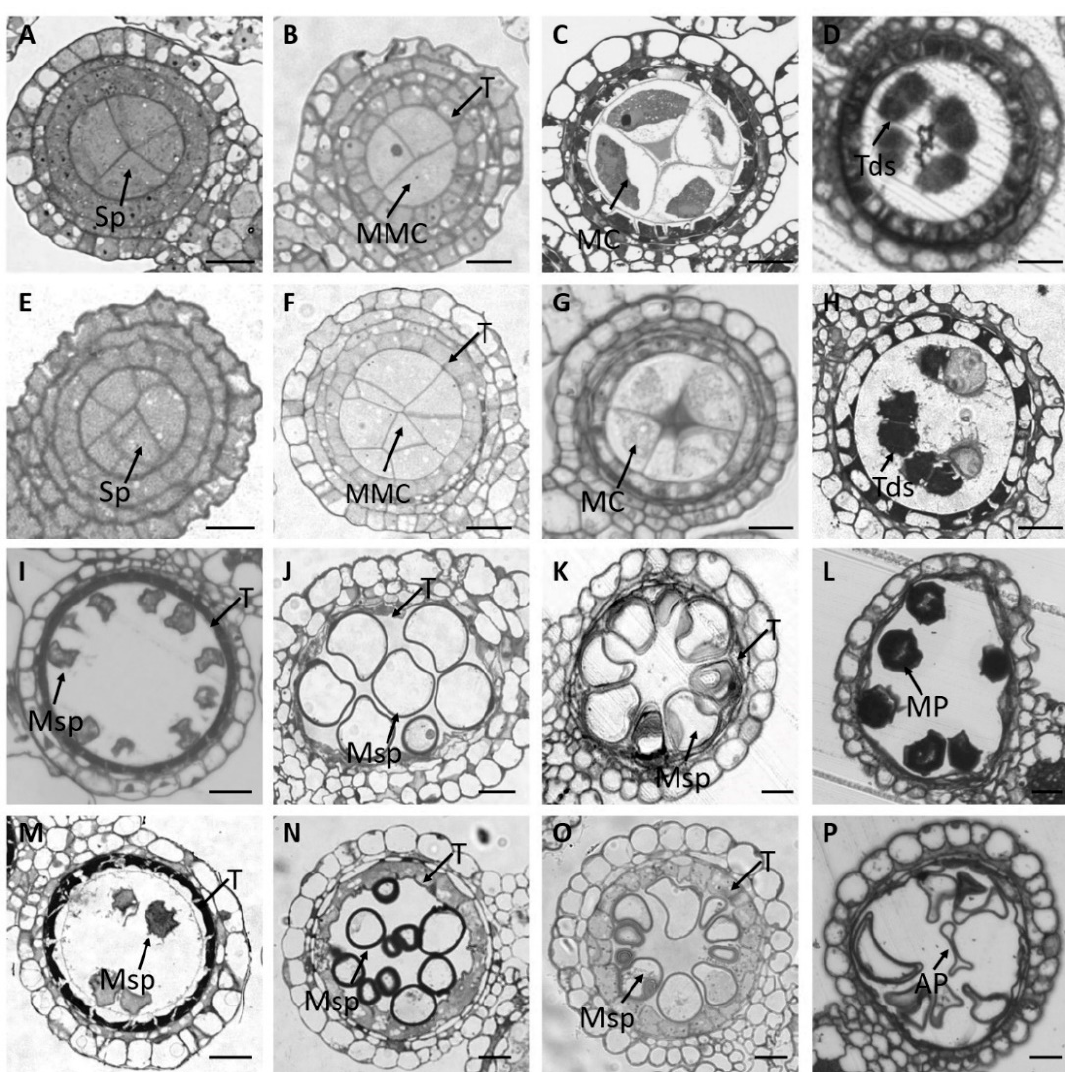
Figure 2. Abnormal development of microspore mother cells and the tapetum in osmads58 CRISPR according to stamen semi ‐ thin sections. ( A – P ) Semi ‐ thin transverse sections of one lobe of anthers in the wild type ( A – D , I – L ) or osmads58 CRISPR ( E – H , M – P ). ( A , E ) Anthers at stage 4. ( B , F ) Anthers at stage 5, there are more microspore mother cells in the mutant. ( C , G ) Anthers at stage 6. ( D , H ) Anthers at stage 8. ( I , M ) Anthers at stage 9. ( J , N ) Anthers at stage 10, the tapetum remains thick in the mutant line. ( K , O ) Anthers at stage 11. ( L , P ) Anthers at stage 12, abnormal pollen was observed in the mutant. Sp, sporogenous cells; MMC, microspore mother cell; MC, meiotic cell; Tds, tetrads; Msp, microspore; T, tapetum; MP, mature pollen; AP, abnormal pollen. Bars, 20 μ m.